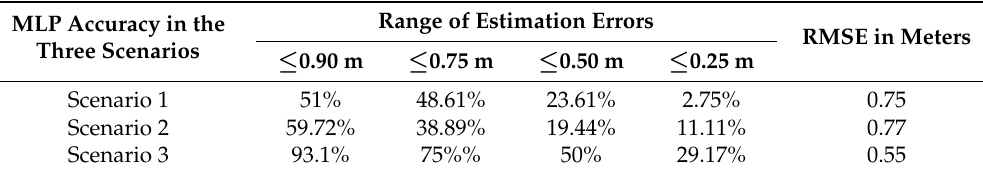
Table 4. Regression-based localization accuracies.